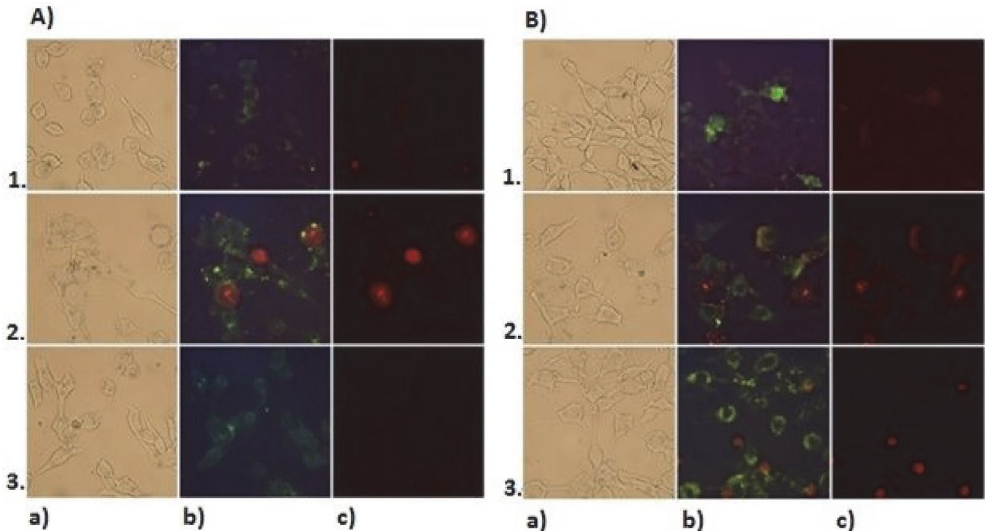
Figure 4. The fluorescent microscopy analysis of apoptosis caused by CLF extracts in the HeLa cells. HeLa cells were treated with A-UE (0.098 mg/ mL) and A-SE (0.079 mg/mL) for 24 h (A) and 48 h (B). The cells were subsequently analyzed by the Carl Zeiss fluorescent microscope: a) visible light b) Annexin V-FITC (green fluorescence) and c) PI (red fluorescence); 1. apigenin standard (positive control) 2. A-UE extract and 3. A-SE ex- tract. Magnification 400